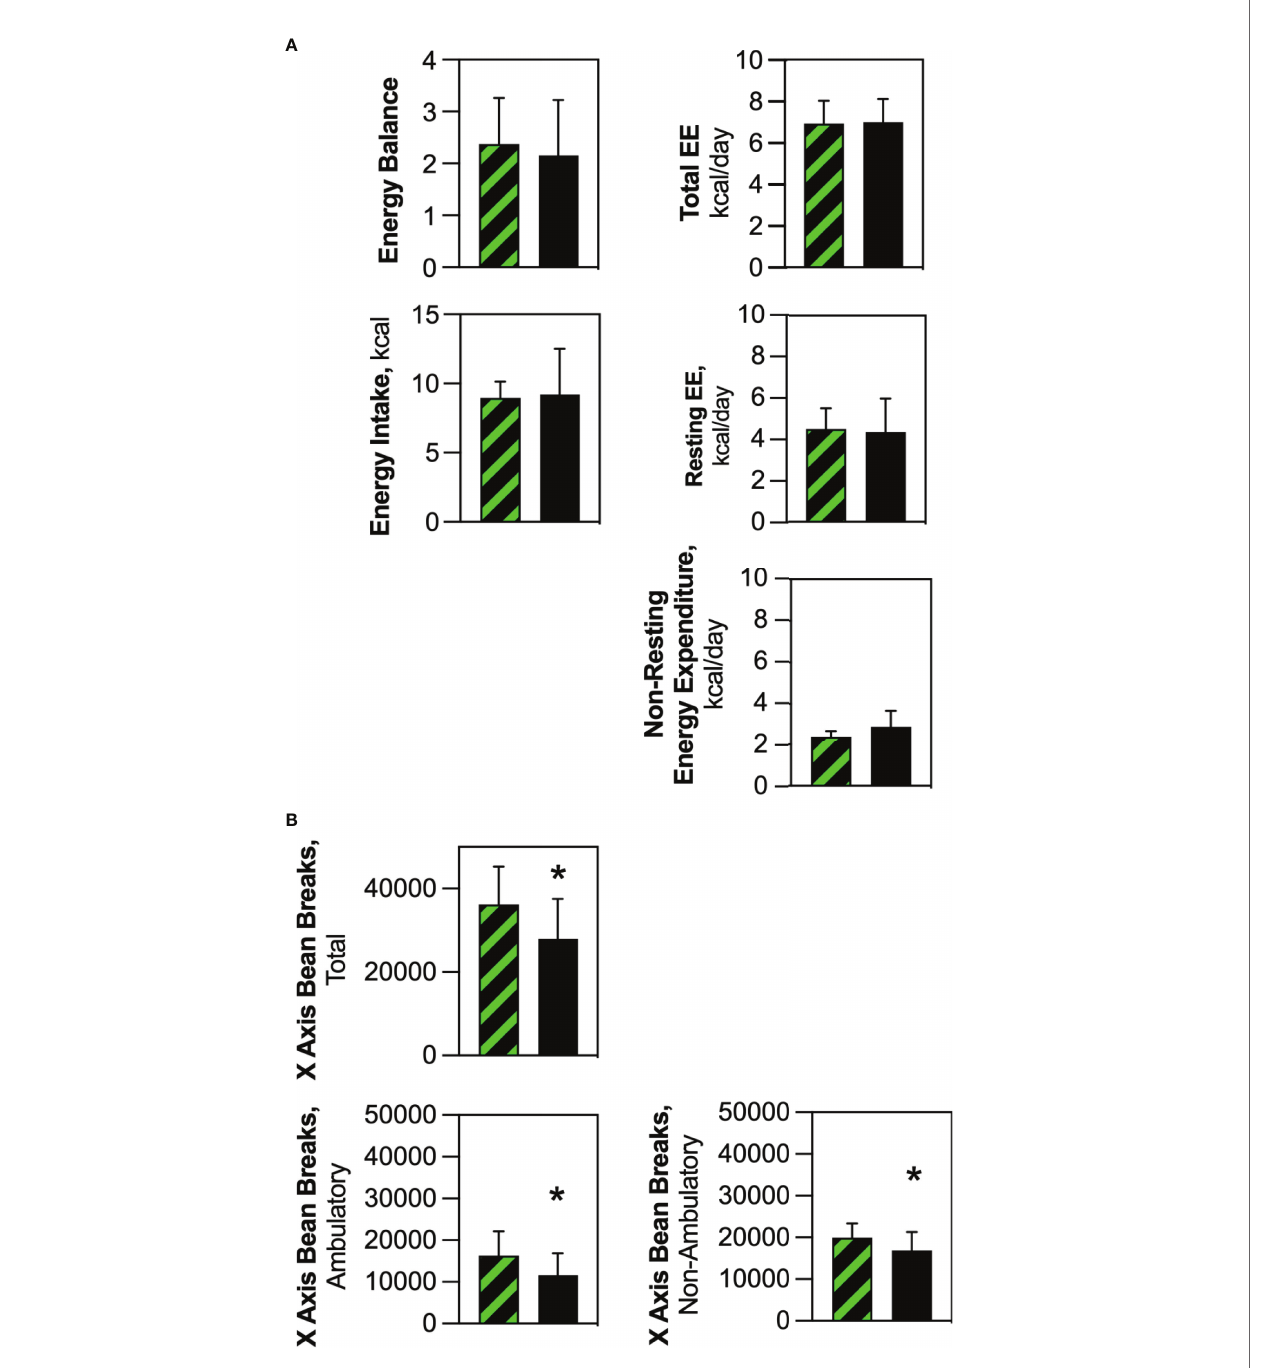
FIGURE 6 | Energy balance, energy intake and energy expenditure were the same in Competent and Ablated mice, but physical activity was signi fi cantly reduced in the Ablated cohort. Individual Competent and Ablated mice were acclimated to calorimetry chambers for 72 hours, after which calorimetric endpoints and physical activity were measured for a period of 96 hours. (A) Energy balance, energy intake and components of energy expenditure (total, resting and non-resting) were averaged over the 96-hour measurement period for Competent (black/green crosshatch bars) and Ablated (solid black bars) cohorts. (B) Components of physical activity (total, ambulatory and non-ambulatory) were measured and averaged over the 96-hour measurement period for Competent (black/green crosshatch bars) and Ablated (solid black bars) cohorts. (n=8 for both cohorts, * indicates p ≤ 0.05